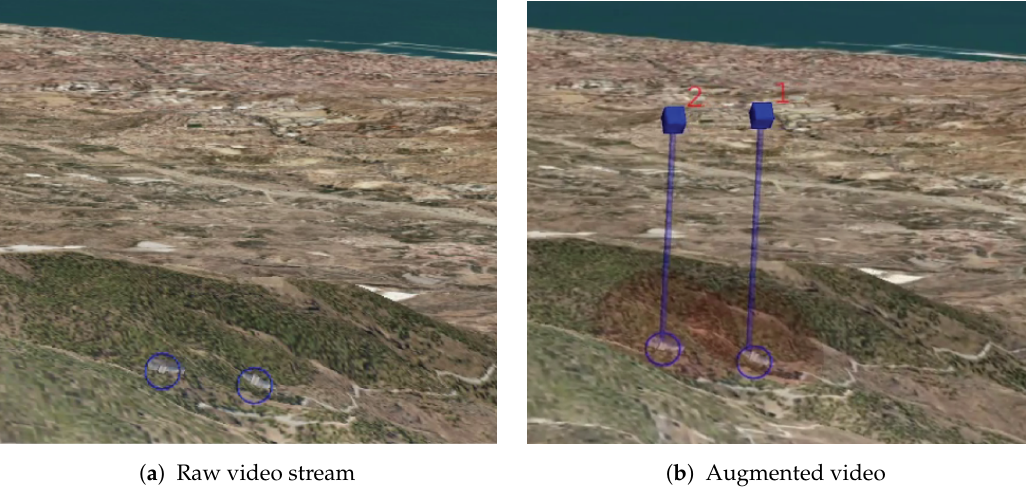
Figure 11. Difference between the raw video stream ( a ) and the augmented with the proposed AR tool ( b ) for distinguishing buildings in reconnaissance missions. A blue circle surrounding the targets has been superimposed on both images to mark the true